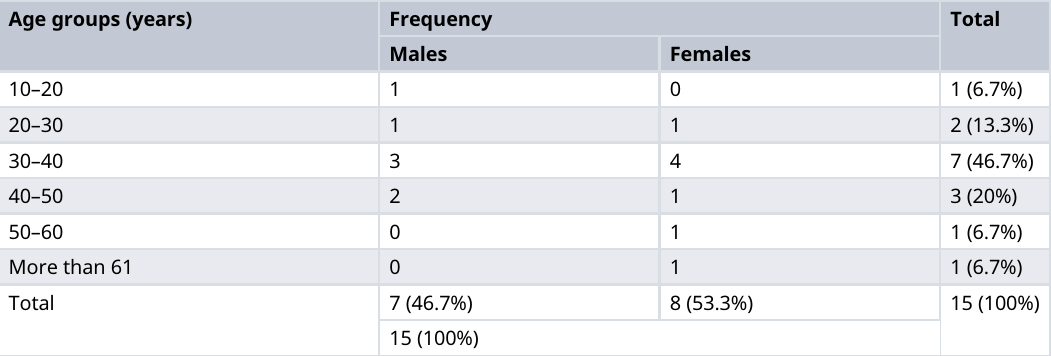
Table 1. Frequency of study subjects according to age